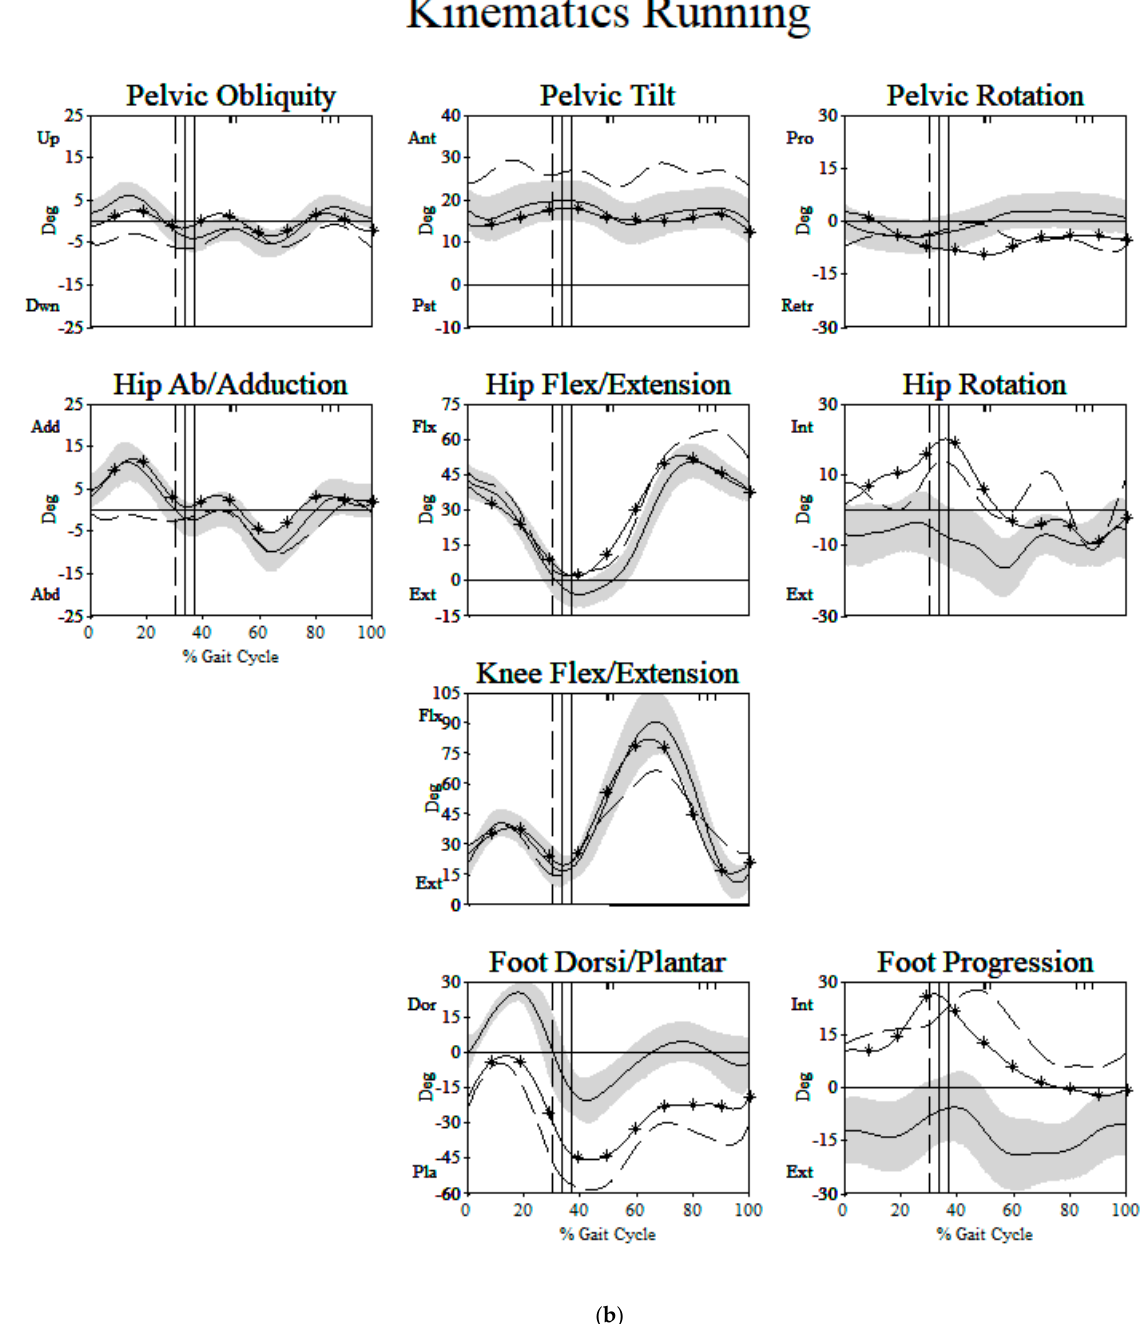
Figure A2. Two examples of children with cerebral palsy from the Spokane Center (Subject 1 dashed line, Subject 2 solid line with * symbols) are shown compared to typically developing subjects average (solid black line) and standard deviation (gray band). ( a ) For walking, subject 1 had a GDI of 71 with deviations largely occurring at ankle, foot progression, hip ab/adduction, pelvic obliquity and pelvic tilt. Subject 2 also had a GDI of 71 with deviations largely occurring in sagittal plane ankle, knee, hip and rotation plane pelvis, hip and foot progression. ( b ) For running, subject 1 had a lower GDI of 59 with greater deviations than subject 2 largely occurring at in sagittal plane ankle, knee, hip, and pelvic tilt and frontal plane hip ab/adduction and pelvic obliquity. Subject 2 remained at a GDI of 71 with deviations largely occurring in sagittal plane ankle and rotation plane pelvis, hip and foot progression.